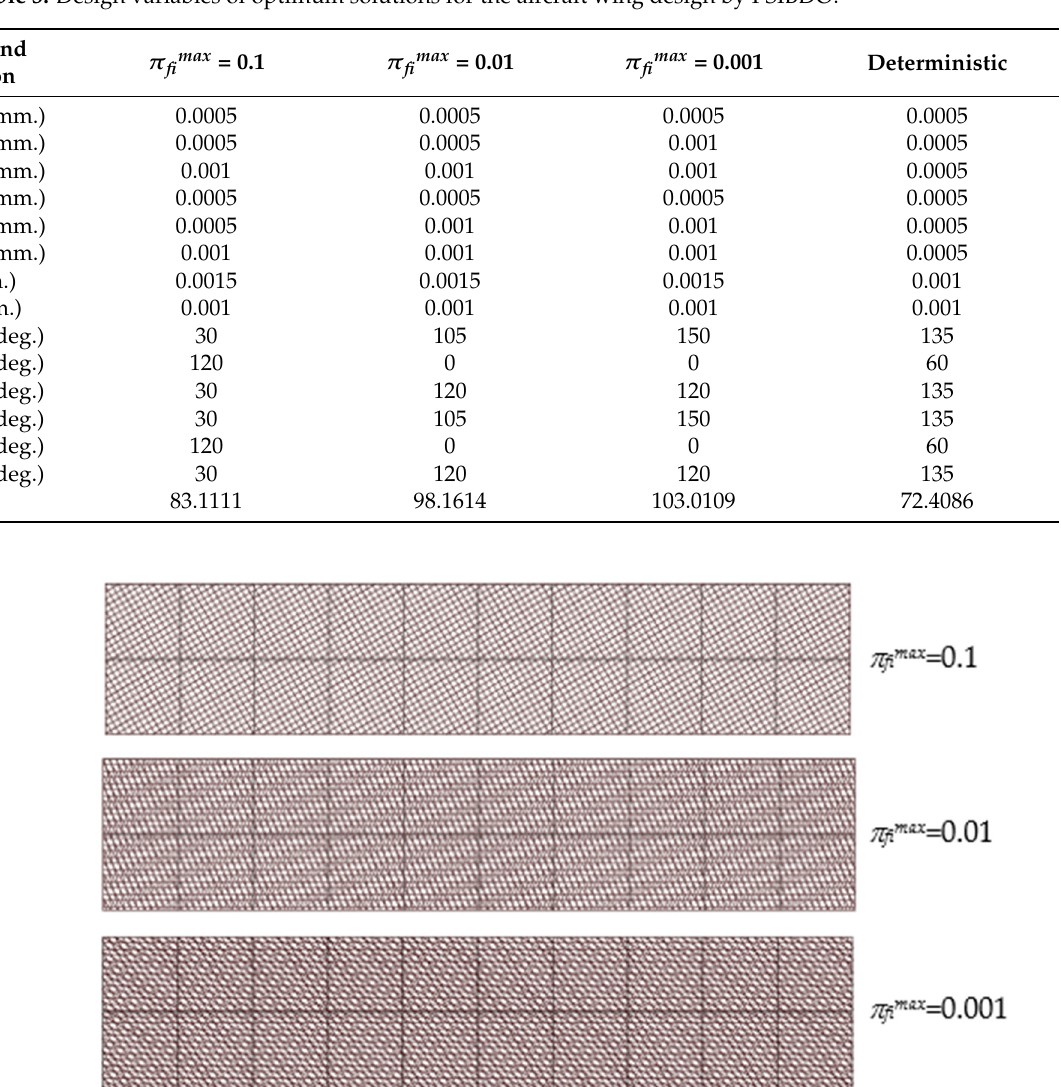
wing is subject to the aerodynamic